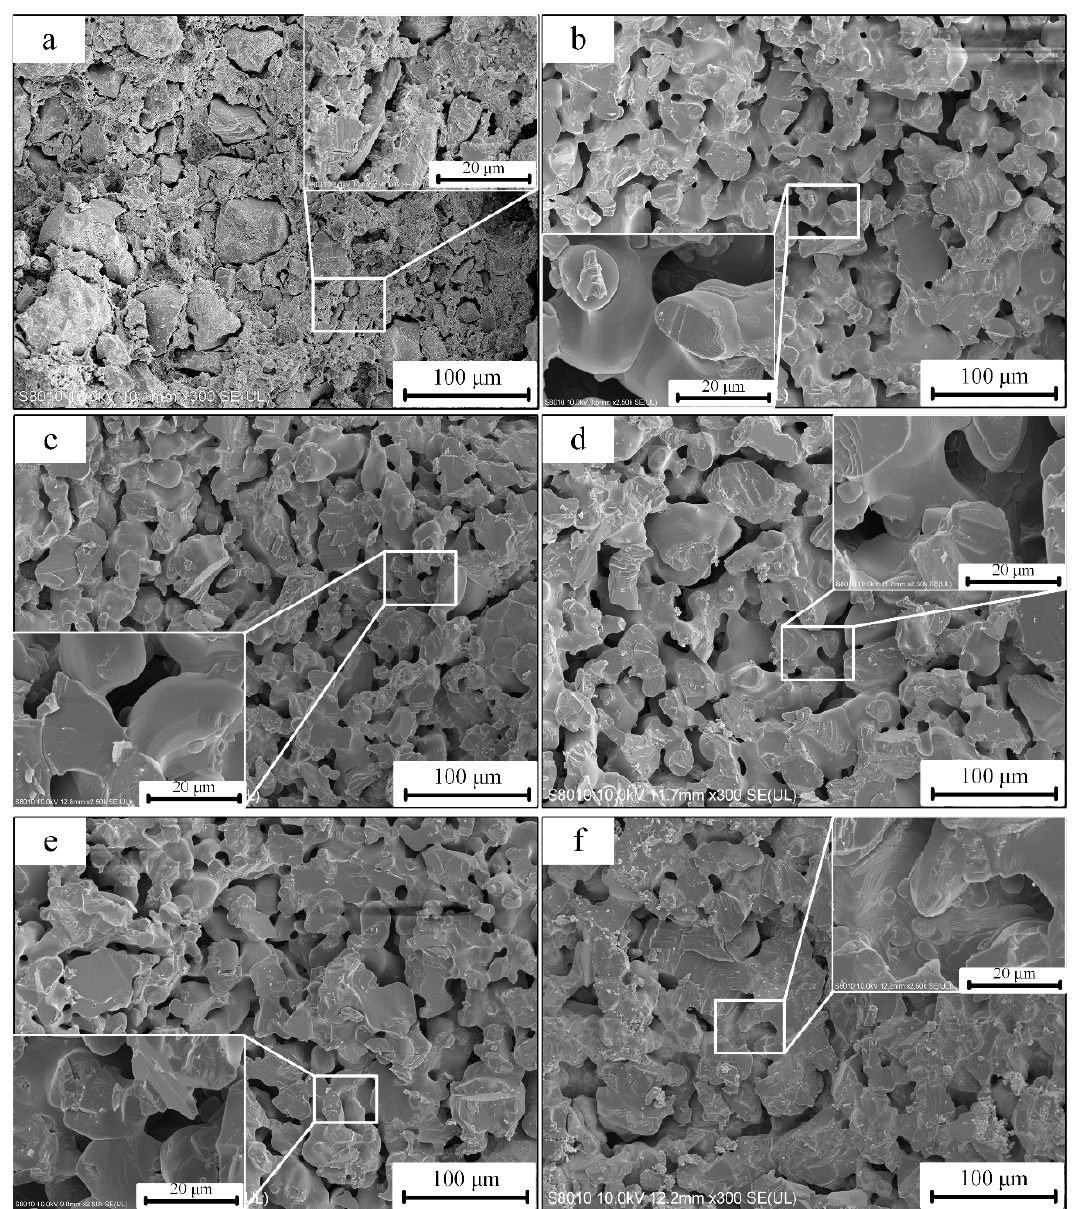
Figure 10. SEM of the fracture surface of green body and sintered samples with different sintering temperatures: ( a ) green body, ( b ) 1350 °C, ( c ) 1400 °C, ( d ) 1450 °C, ( e ) 1500 °C, ( f ) 1550 °C.